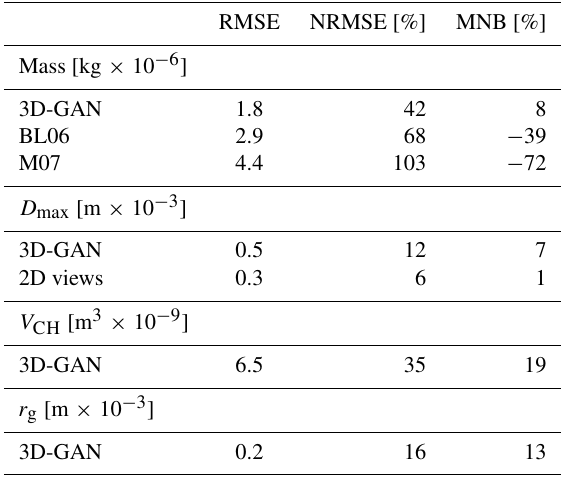
Table 2. Summary of root-mean-square error (RMSE), normalized RMSE (NRMSE, normalized on the mean value of reference data) and mean normalized bias (MNB) resulting from the comparison with the 3D-printed snowflake replicas.